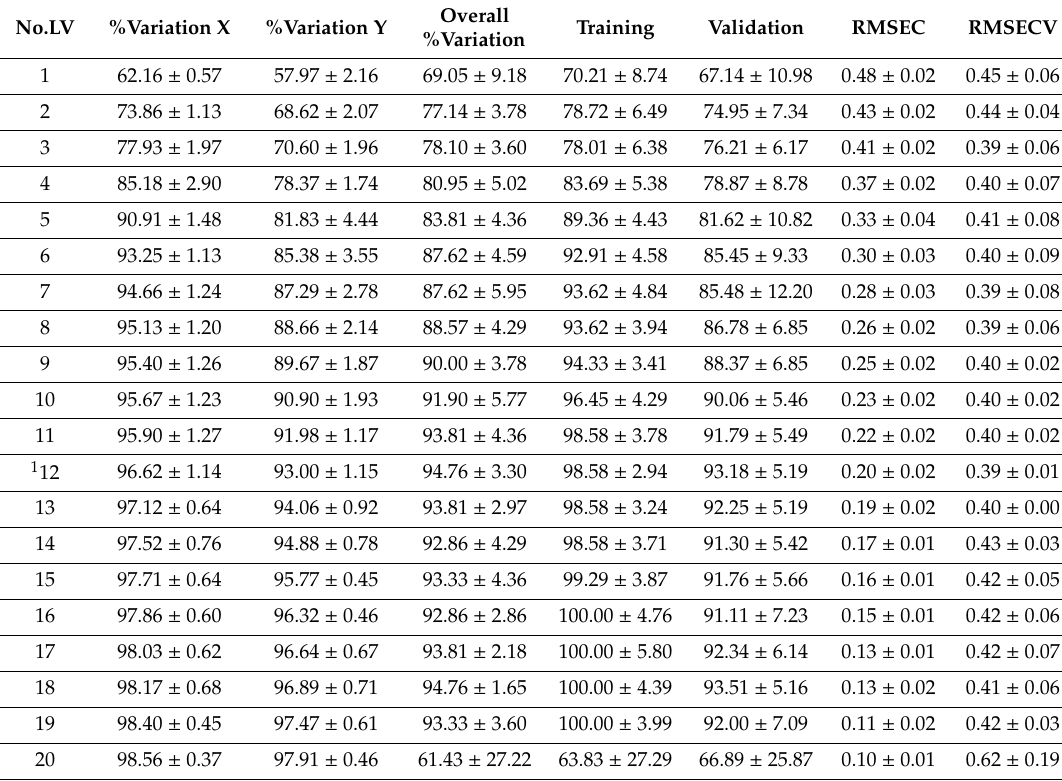
Table 2. Compiled output obtained from the analysis of the three di ff erent splits carried out in Discriminant Multi-Way Partial Least Squares Regression